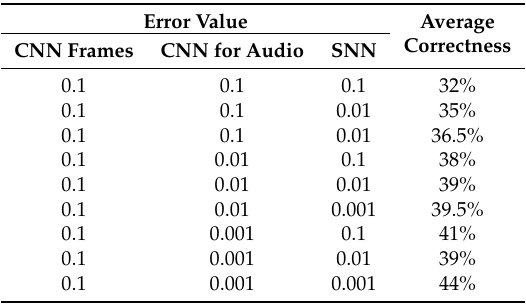
Table 1. Average correctness for various neural compositions applied for User 1. CNN: convolutional neural network; SNN: spiking neural network.